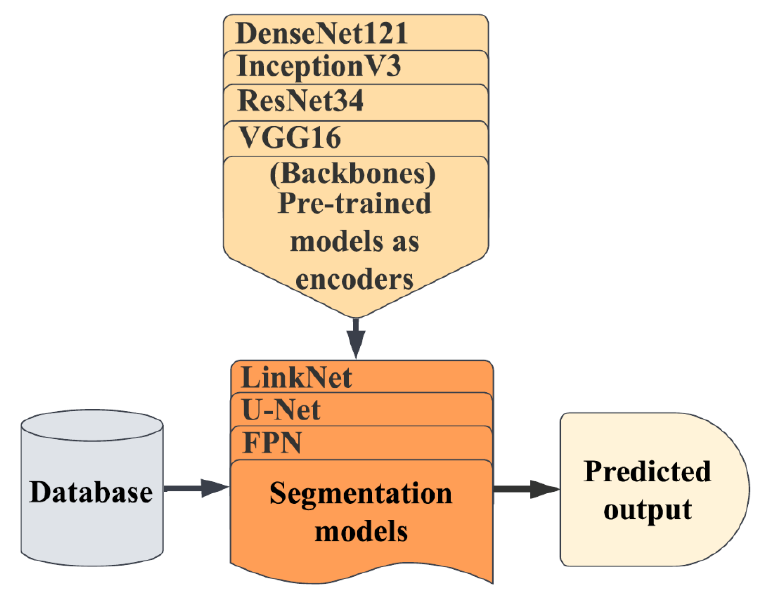
Figure 2. Flowchart of the semantic segmentation experiment using the transfer learning technique.